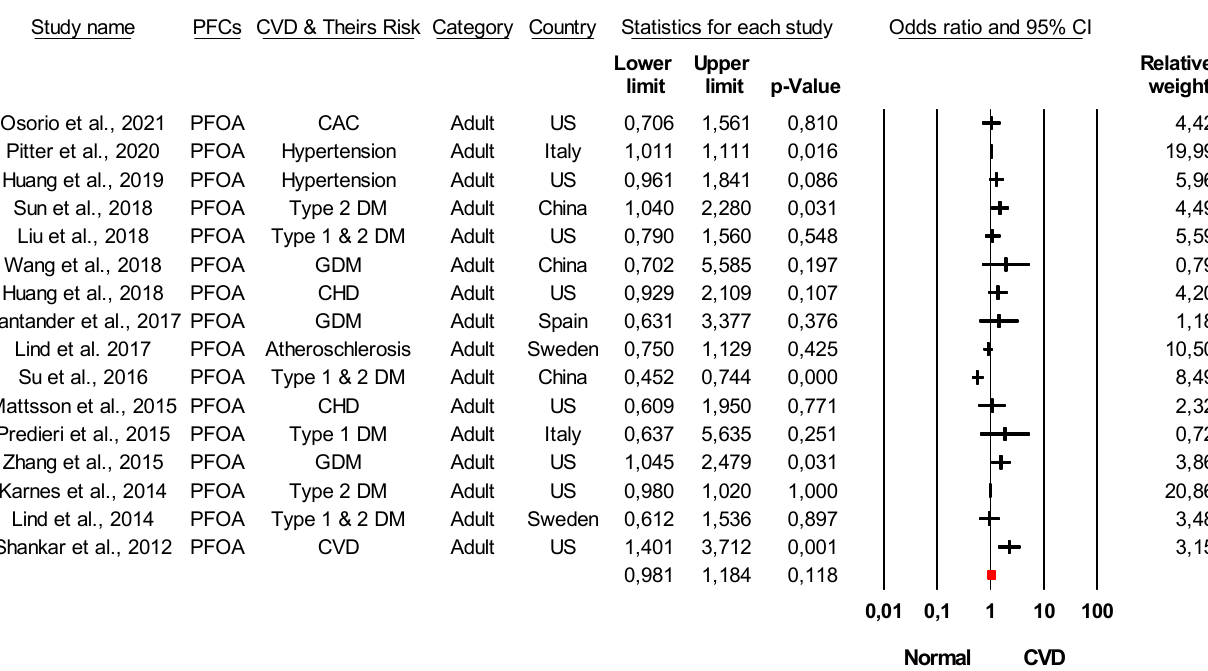
Figure 4. Meta-analysis of studies of PFOA exposure and CVDs and their risk using the random-effects model, ordered by date of publication. Stratified analysis of PFOA as the unit of analysis within the study was selected. CAC = coronary artery calcium, DM = diabetes mellitus, GDM = gestational diabetes mellitus, CHD = coronary heart diseases. Test for overall effect: z = 1.56, p = 0.12; Test for heterogeneity: I 2 = 72.1% Q = 53.78 df = 15, p <